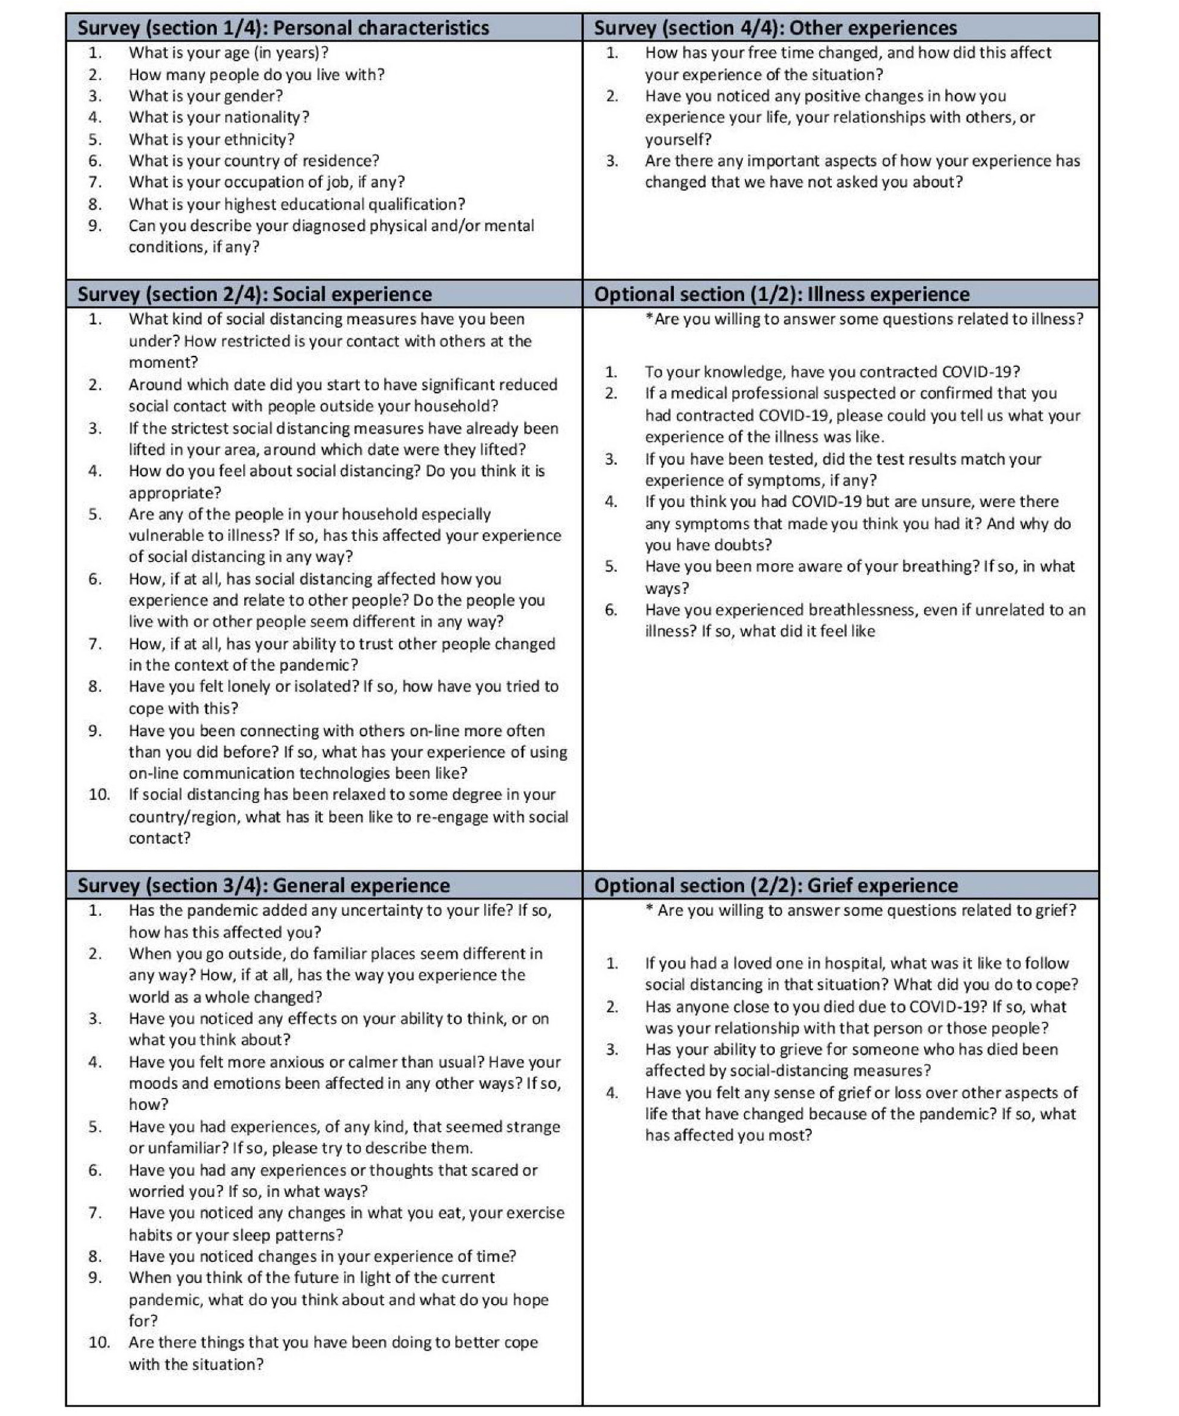
FIGURE1 Questionnaire consisting of six sections highlighted in distinct colors with a total of 42 questions. The same set of questions was used in Survey I also (1). Section 1 (“Personal characteristics”) consisted of nine questions regarding the demographic data and self-described medical history of the participant. Section 2 (“Social experience”) consisted of eight open-ended questions about social experience and two questions regarding the date of lockdown measures. Section 3 (“General experience”) consisted of 10 open-ended questions about general experiences, such as the subjective experience of time and space and coping mechanisms. Section 4 (“Other experiences”) consisted of three questions about other experiences, like the occurrence of any positive changes and hopes for the future. Section 5 (“Illness experience”) consisted of six questions related to experiences of illness. Section 6 (“Grief experience”) consisted of four questions about the experience of